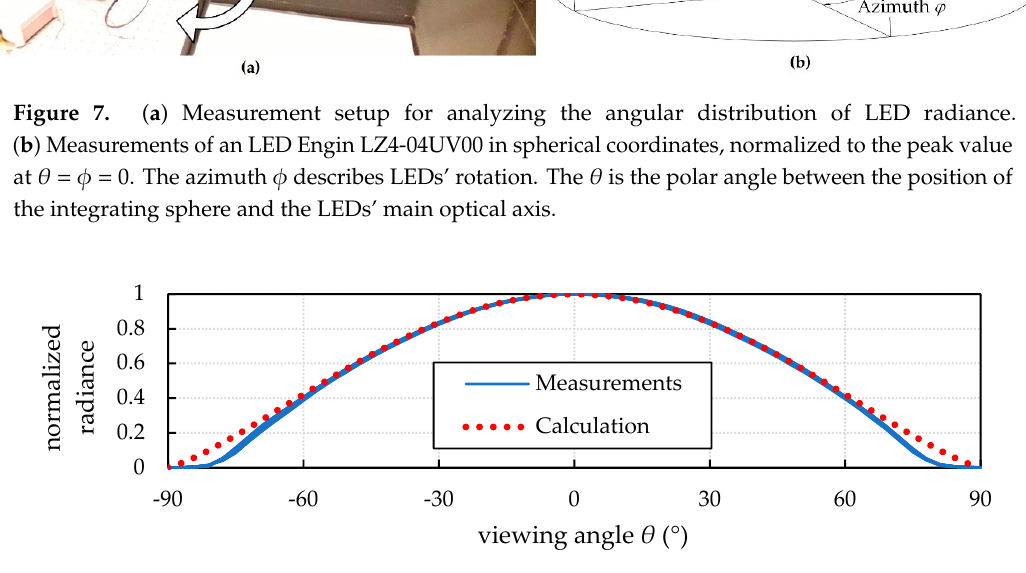
Table 1. Optimized values for the LED power and required settings. Due to variations in the individual radiance of the LEDs, some of them had to be operated at different currents to obtain the same output power. LEDs are numbered as they are in Error! Reference source not found. a.